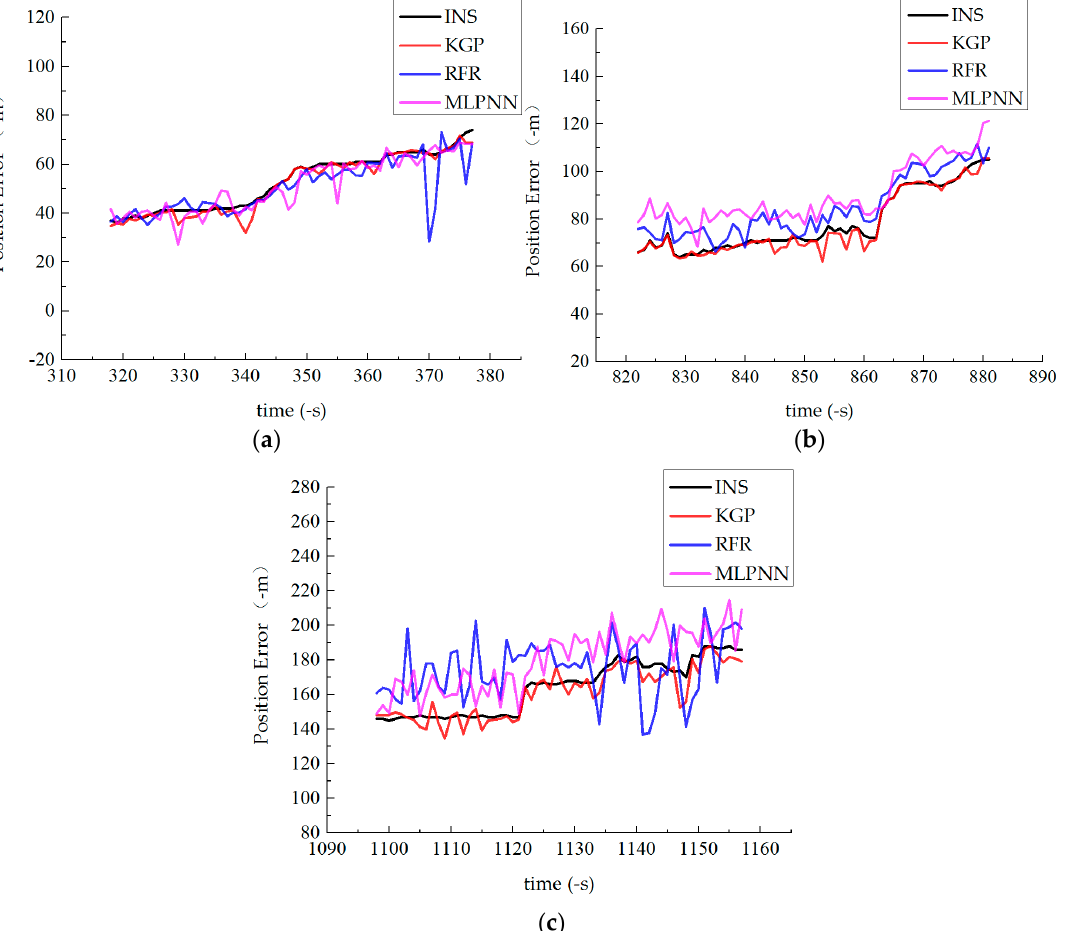
Figure 10. Comparison results of different algorithms in position errors: ( a ) phase 1, ( b ) phase 2 and ( c ) phase 3.